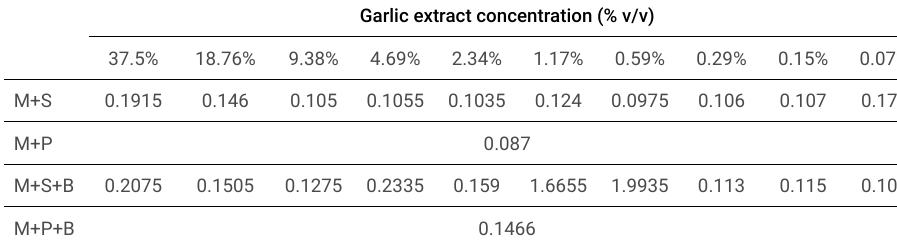
Table 3. Results of the Minimum Biofilm Eradication Concentration